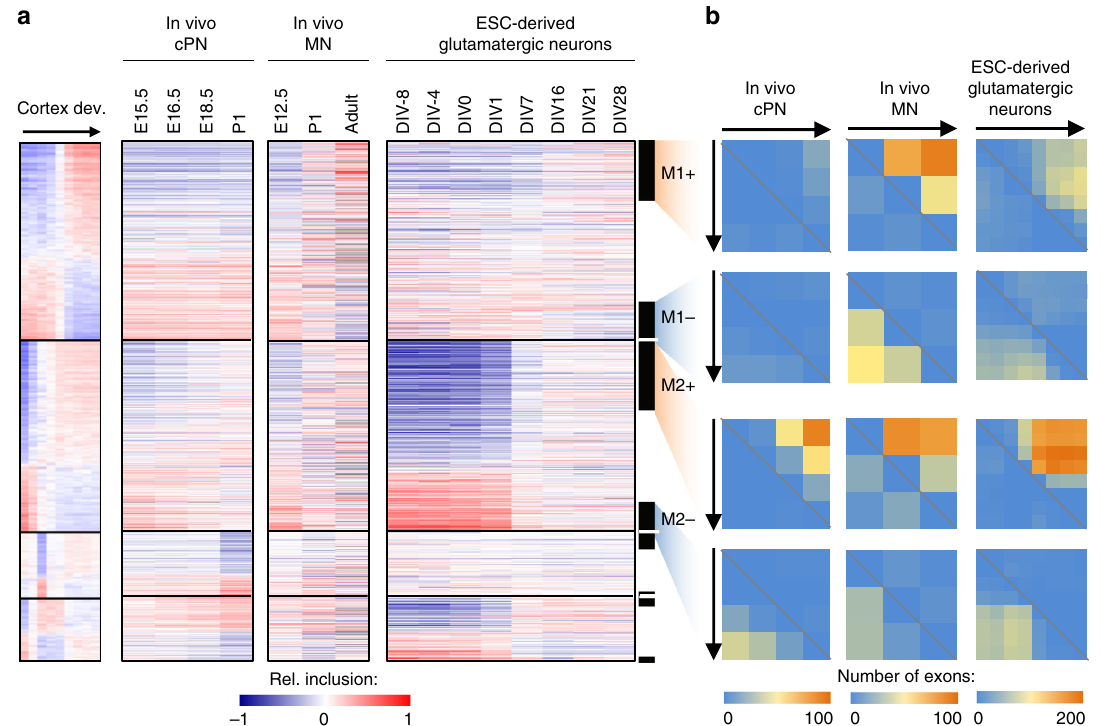
Fig. 2 The modular organization of the developmental splicing program is pan-neuronal. a The splicing pro fi le of module exons in different neuronal subtypes. Exons are shown in the same order as in the cortex reference. DIV: days in vitro. For differentiation of glutamatergic neurons from ESCs, cells on DIV 0 are enriched in radial glia committed to the neuronal fate, which becomes post-mitotic on DIV 1. b Quanti fi cation of developmental splicing switches among module exons in different neuronal subtypes. In each dataset, M1 + /M1 − and M2 + /M2 − core module exons also showing differential splicing (| ΔΨ | ≥ 0.2, Benjamini FDR ≤ 0.05) in each pairwise comparison were counted. The number of exons showing increased inclusion at later time points is shown above the diagonal (top right), and the numbers of exons showing decreased inclusion is shown below the diagonal (bottom